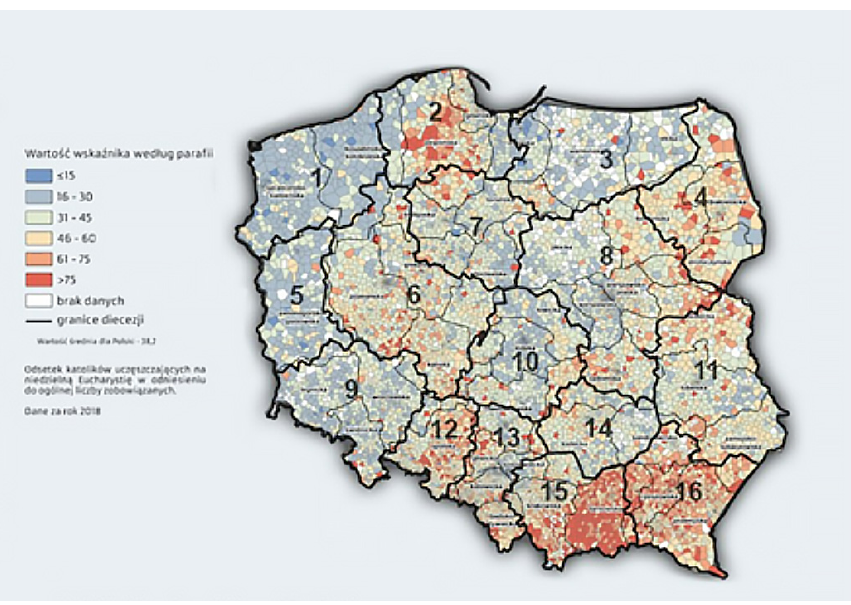
Figure 13. Religiosity in Poland 2021; source: https://www.gis-expert.pl/mapy-religijnosci-polakow (accessed on 23 August 2021).